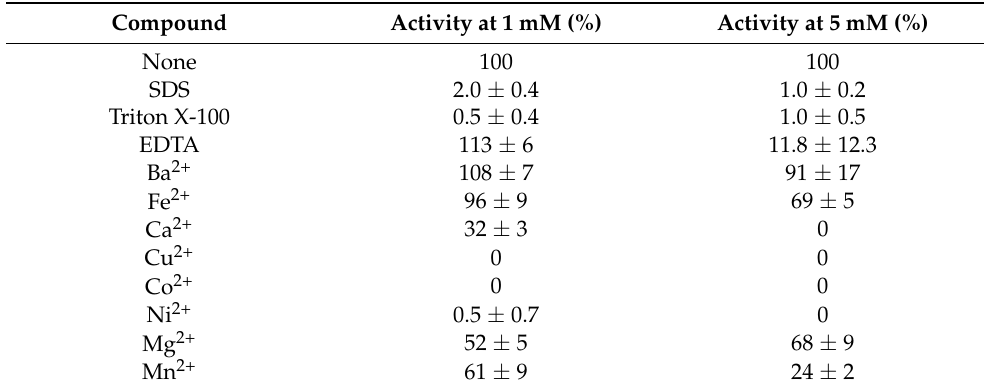
Table 1. Effects of two concentrations of various divalent cations and other substances on Hmc Isc activity. Error bars represent standard error values for three